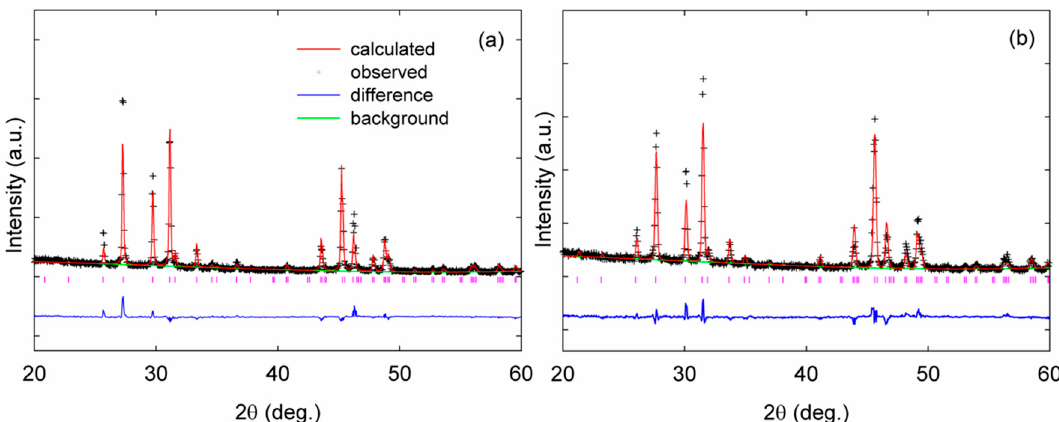
polycrystalline specimen.